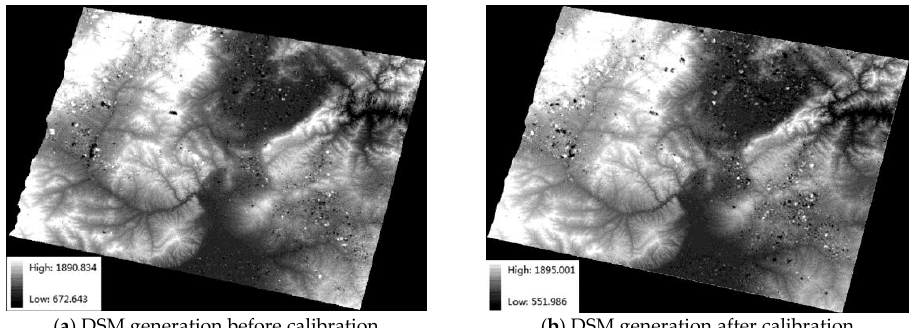
Figure 5. DSM generation. Figure 7. DSM